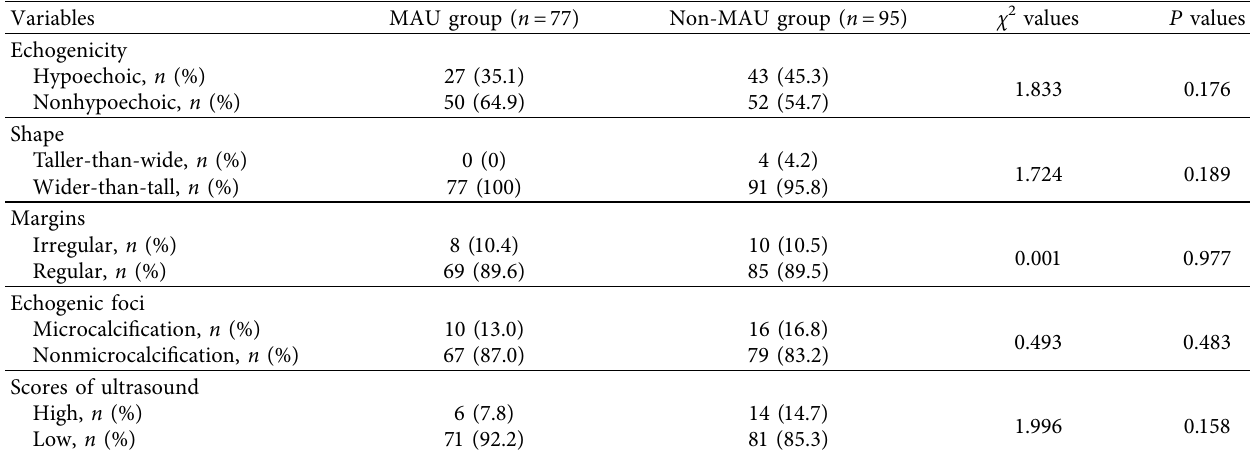
Table 4: Ultrasound features of thyroid